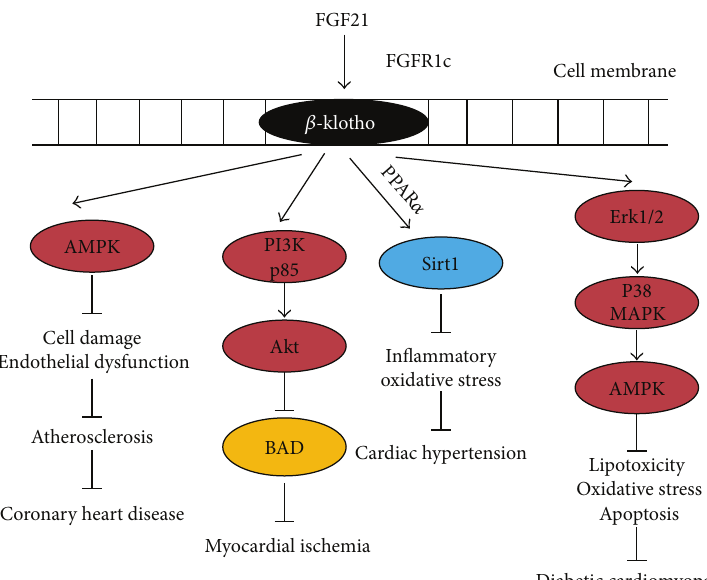
Figure 1: FGF21 induces preventive effect on CVDs through multiple signaling pathways. As a classical cytokine, FGF21 functions as a metabolic regulator by binding with its receptor FGFR1 or FGFR2 in the presence of 𝛽 -klotho. Growing studies demonstrated that FGF21 also induced beneficial effects on CVDs probably due to inhibition of glucose or lipid metabolic disorders. For instance, FGF21 prevented atherosclerosis and the subsequent CHD by inhibition of lipogenesis which was also the possible mechanism of FGF21-induced preventive effect on CH. Additionally, FGF21 also prevented MI and DC by activation of Akt- and AMPK-mediated signaling pathway which were usually involved in maintaining glucose and lipid